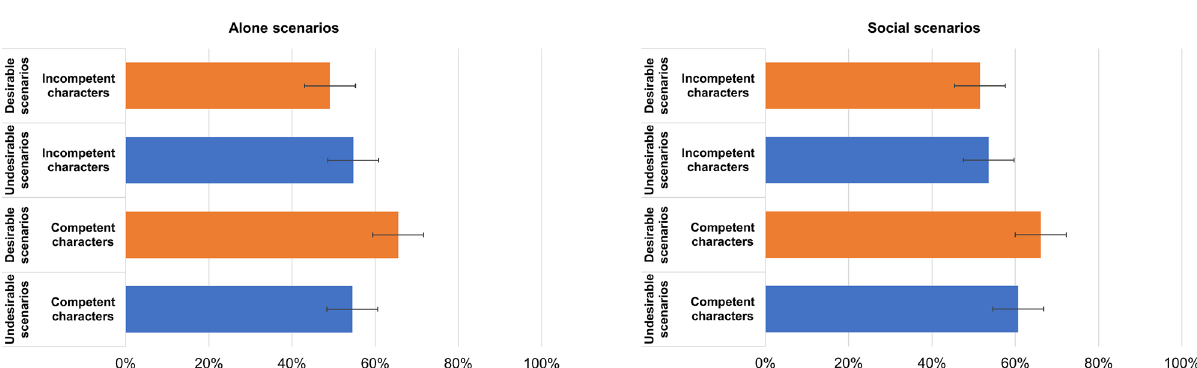
Figure 1. Interaction effect between warmth, valence and sociality of outcomes. The bars represent 95% confidence intervals.